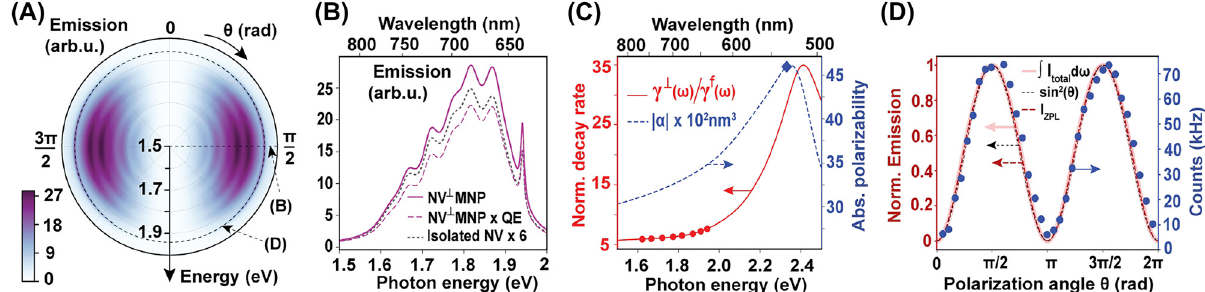
Figure 2: Experimental comparison of NV spectra under plasmonic influence. (A) Polar contour plot of NV emission intensities for the setup = 30 nm located at R = 38 nm from the NV center in air. (B) NV Emission in Figure 1(B), in the presence of a gold nanoparticle of radius r m intensity spectrum of the same NV-MNP setup obtained at 𝜃 = 𝜋 ∕ 2 radians. The solid purple line shows the total NV emission and the long-dashed purple line shows the approximate far-field NV emission accounting for the MNP induced nonradiative losses of the emitted photons. The latter is obtained by scaling the total NV emission by the quantum efficiency (QE) ∼ 0.78 reported for the setup in [3], which assumes a QE ∼ 0 . 99 for the bare NV center. Dotted curve depicts the spectrum of the isolated NV center magnified six times. (C) Modified decay rate spectrum (red curve) for a generic emitter oriented perpendicular to the aforementioned MNP surface, normalized by the respective free-space emission rate 𝛾 f ( 𝜔 ). Red circles capture the normalized decay rates for NV ⊥ MNP ( 𝜃 = 𝜋 ∕ 2) case for the NV emission band peaks. The dashed blue curve depicts the absolute polarizability of the MNP, and its value at the input laser frequency (532 nm wavelength) is marked with the blue diamond. (D) Comparison of the calculated ZPL and integrated emission intensities against the experimentally detected photon counts in [3]. All emission values are normalized by the area of the isolated NV center spectrum at 𝜃 = 𝜋 ∕